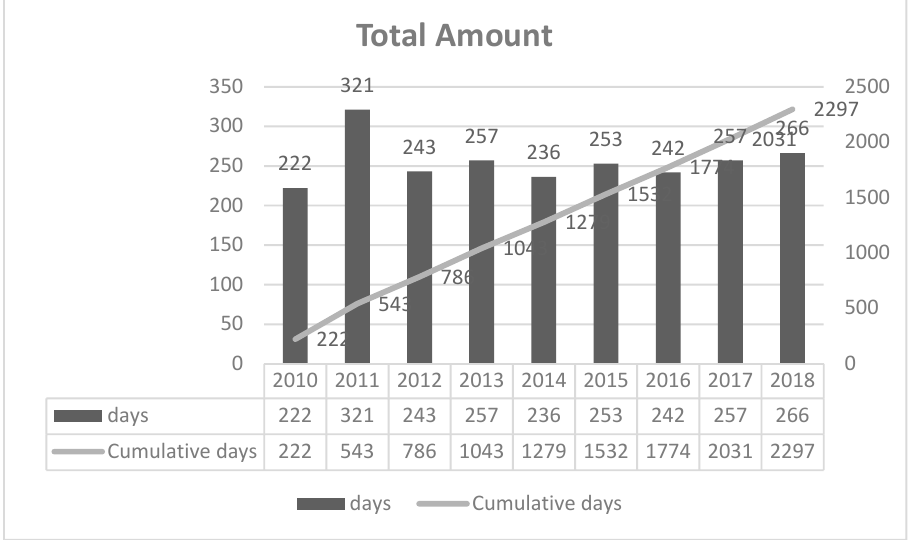
Figure 14. Cumulative days table of the number of activities of Kaohsiung Dome in 2000–2018.